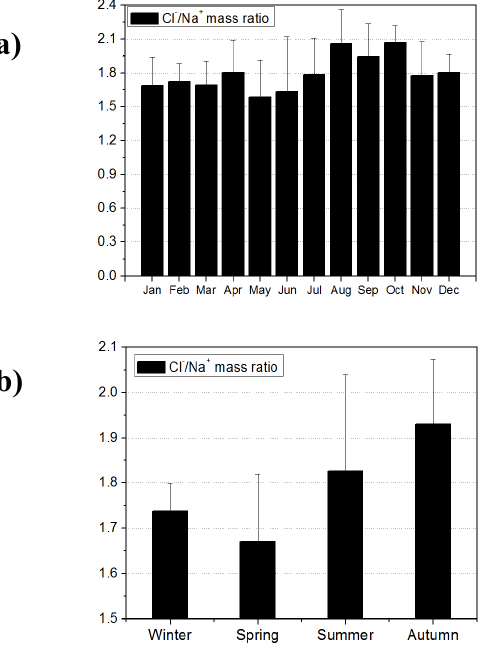
Figure 9. Variation of the Cl − / Na + mass ratio on (a) monthly and (b) seasonal